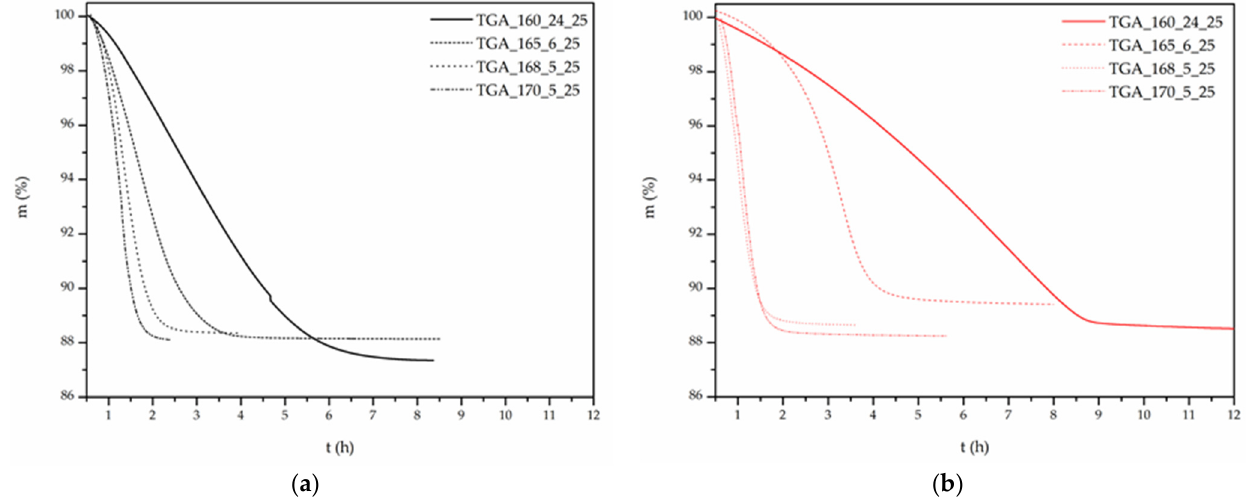
Figure 5. DSSP curves of ( a ) fossil-based and ( b ) bio-based PA 612 salt. Table 4. Mass loss and t 1/2 for the DSSP of fossil-based and bio-based PA 612 salt.